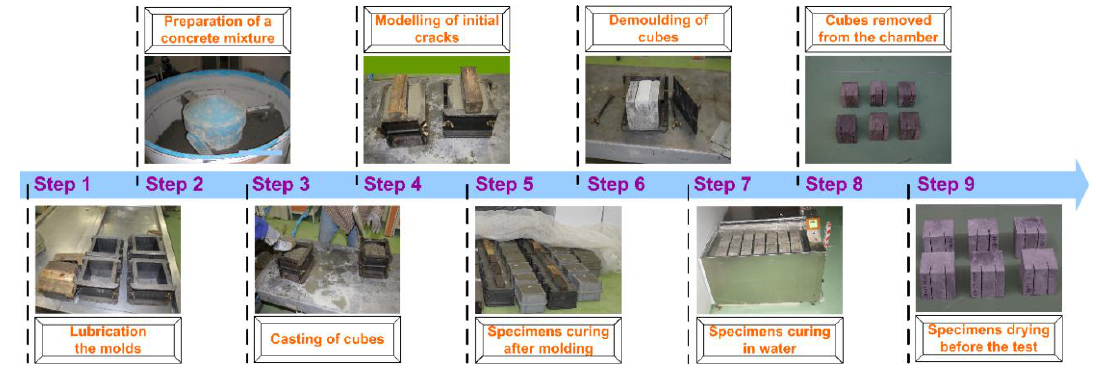
Figure 2. Preparation process of the specimen for fracture toughness tests.